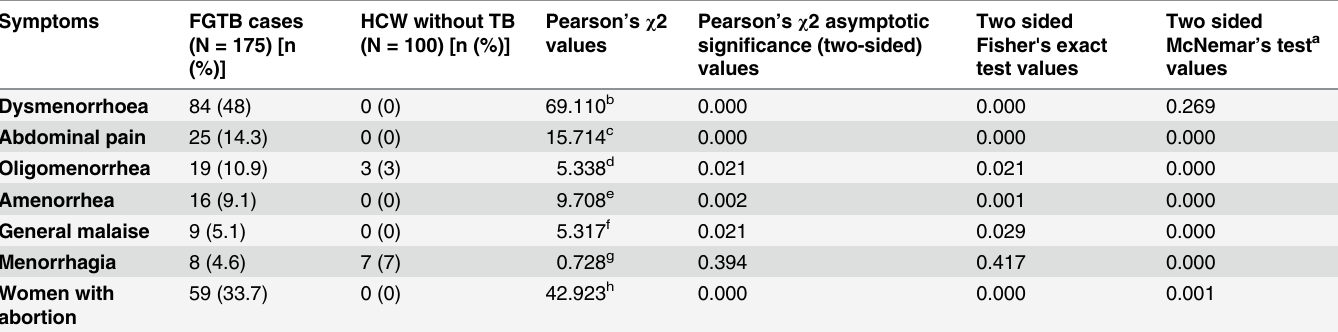
Table 4. Arithmetical association of menstrual problems among infertile women with FGTB and HCW without TB.